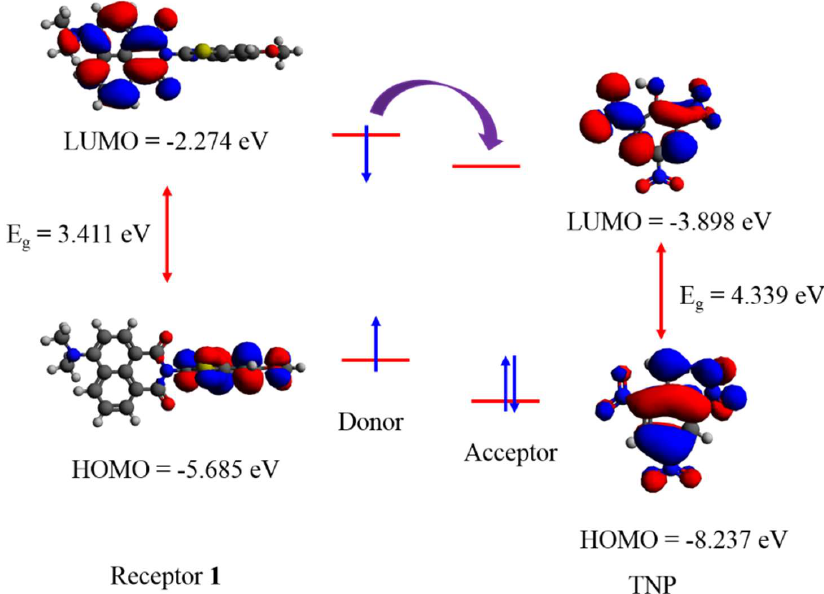
Figure 4. Frontier molecular orbital diagram with energy in eV of receptor 1 and TNP ( A1 ) showing donor-excited photoinduced electron transfer (d-PET).